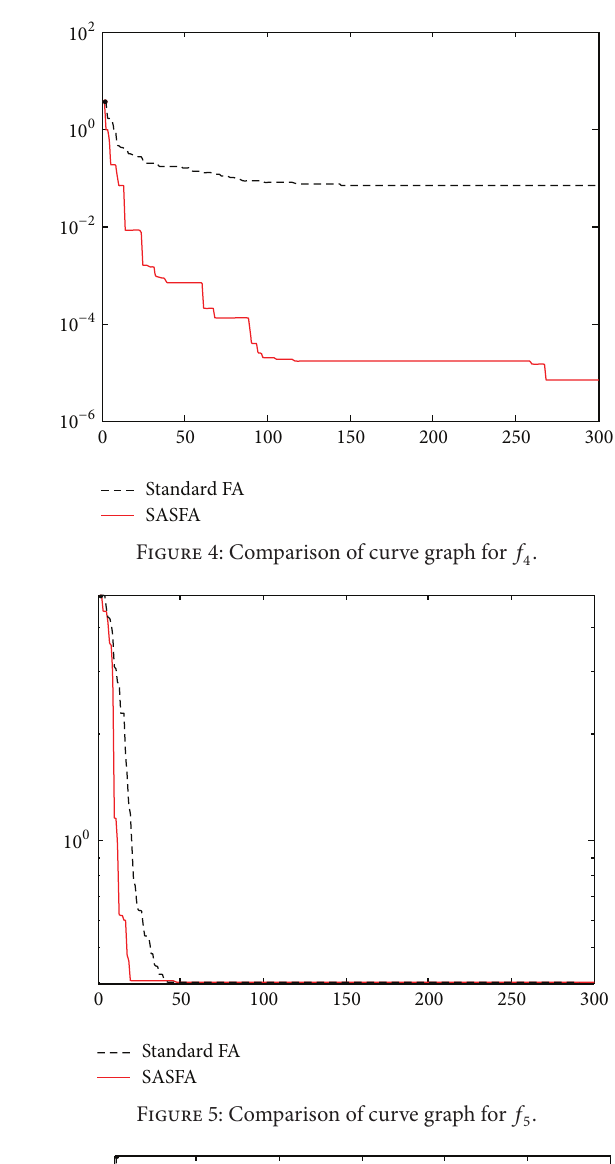
Figure 2: Comparison of curve graph for 𝑓 2 .